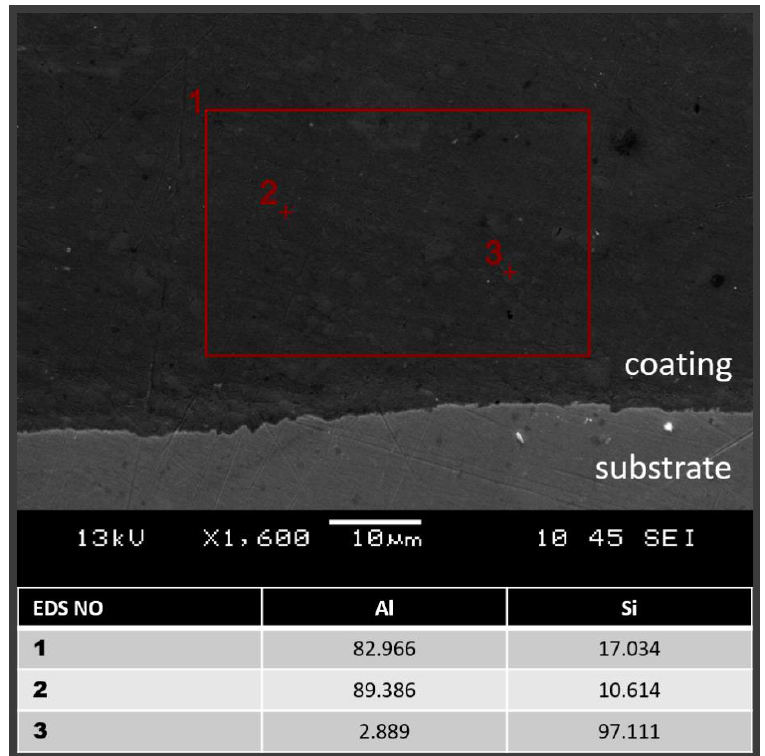
Figure 6. SEM image of mechanically alloyed coating and EDS results of marked areas.